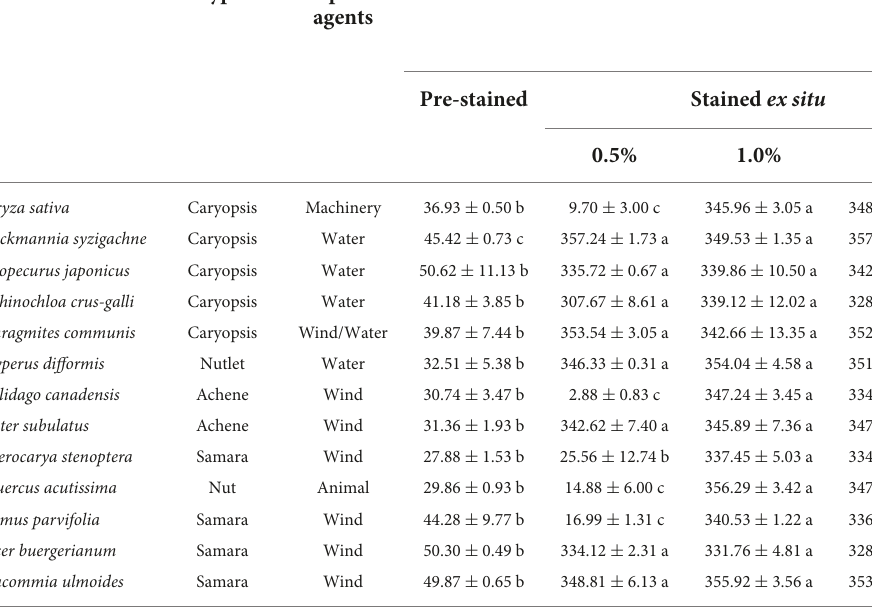
TABLE 2 Comparison of seed colors, staining and drying